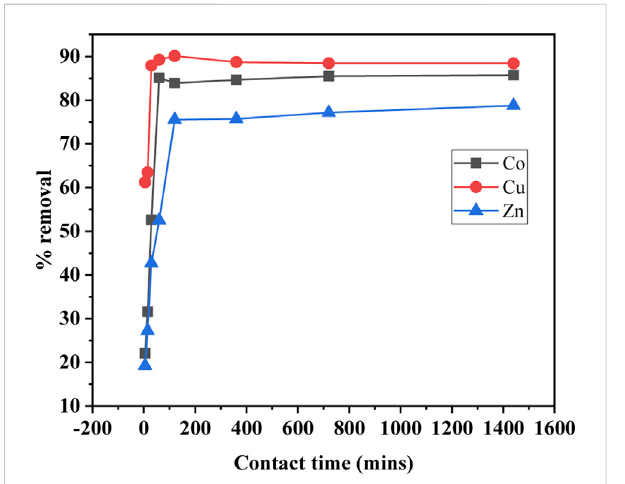
FIGURE 4 Initial metal ion concentrations versus the rate of metal ion uptake (Operating conditions; Adsorbent dose 0.1 mg, pH 8, contact time 1.5 h, and temperature 25 °